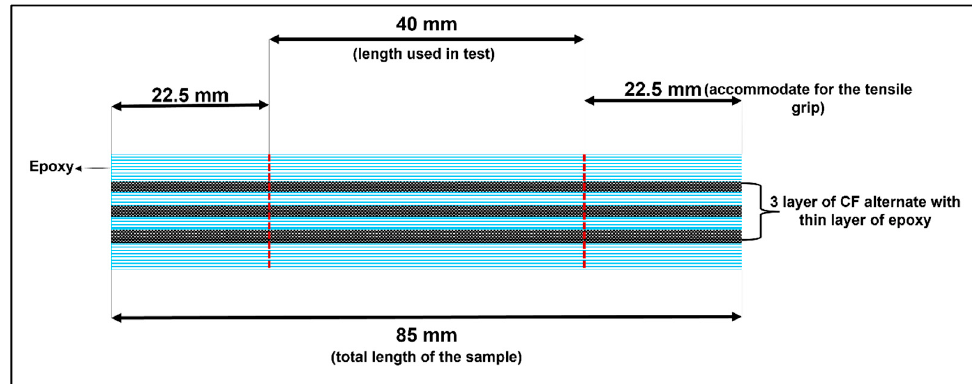
Table 5. Description of the samples.